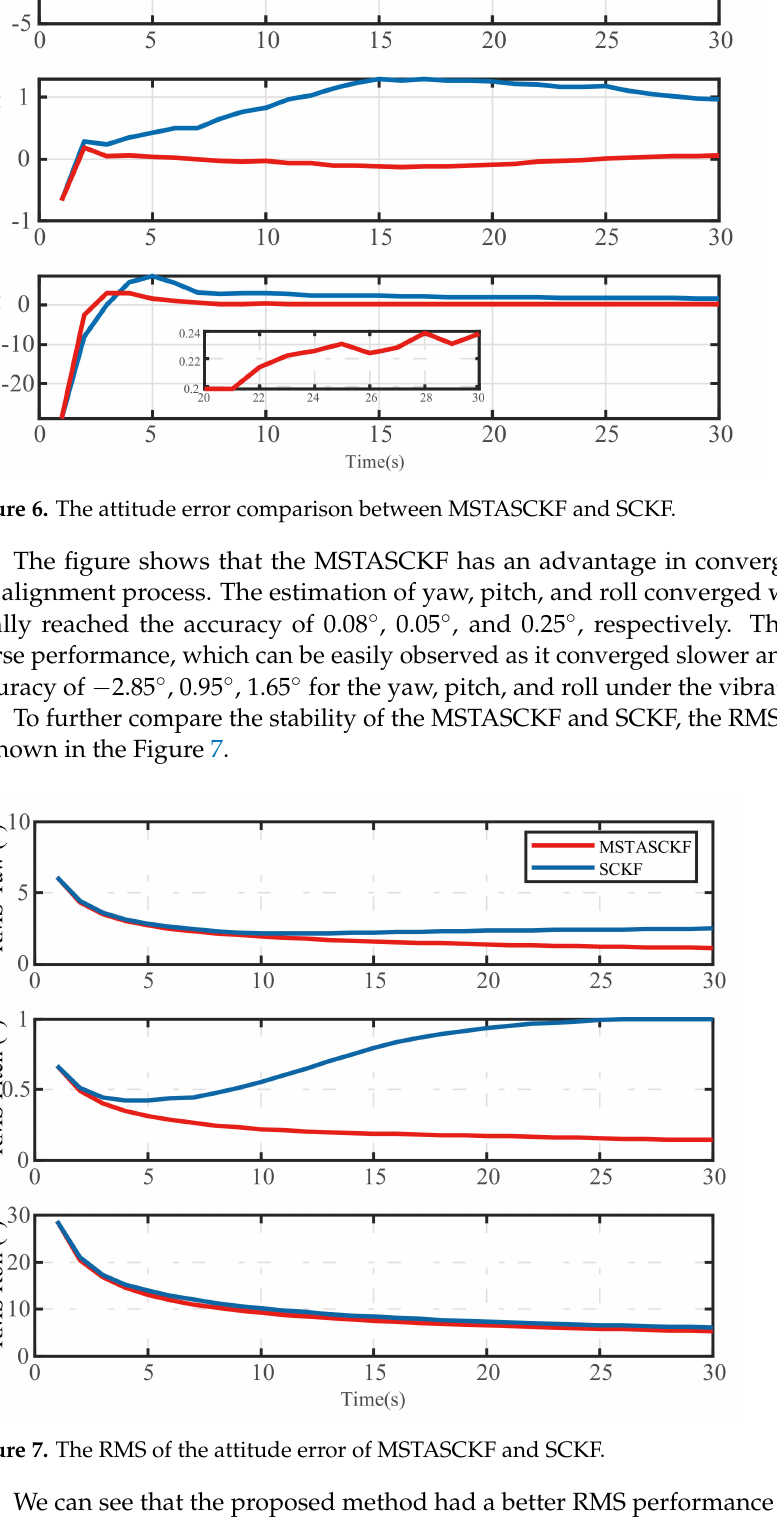
(cid:3) (cid:2) and 2.5 ◦ 0.99 ◦ 6.12 ◦